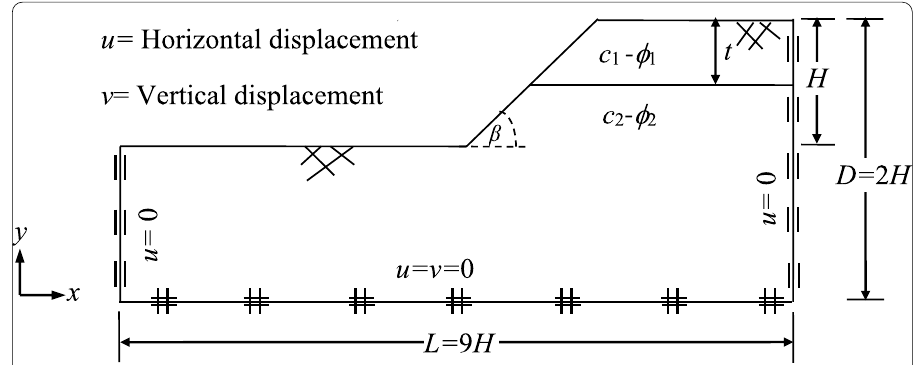
Fig. 1 Schematic diagram and the boundary conditions of a two-layered soil